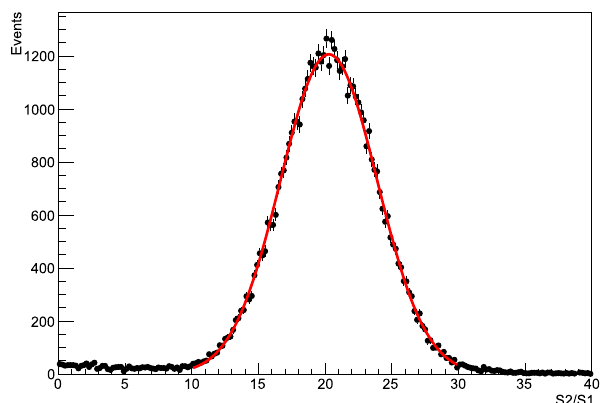
Fig. 14 Distribution of S2/S1 for 241 Am (left) and 83 m Kr (right) mea- sured at E d = 183 V/cm. The events are selected via S1 to only include the full-energy peak. For 241 Am, a Gaussian fit is superimposed to the data histogram to obtain the mean and width (rms) of the distri- bution. For 83 m Kr, the environmental background, normalised on the